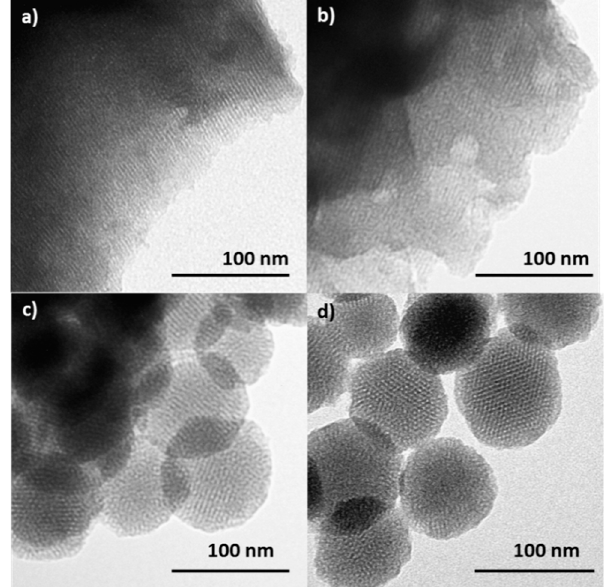
Figure 3. TEM images of calcined ( a ) microparticles ( M ), and ( c ) nanoparticles ( N ), showing the typical hexagonal porosity of the MCM-41 matrix. TEM images of solid MSP micro- and nanoparticles loaded with rhodamine B and functionalized with N3: ( b ) M-Rh-N3 , and ( d ) N-Rh-N3 .